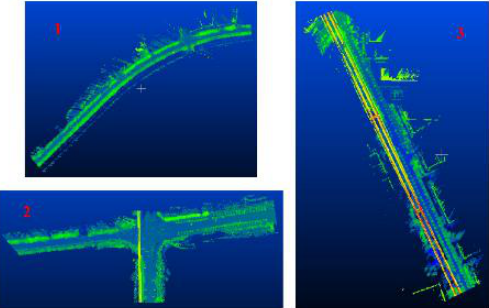
Figure 12. An overview of the experimental data. Table 1. Description of the datasets.